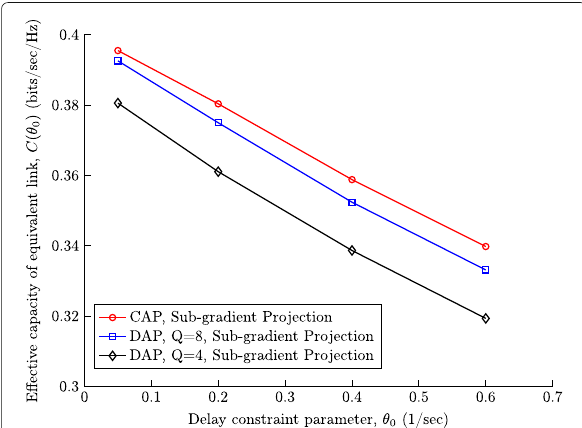
Fig.5 Effectivecapacityversusdelayconstraint, θ 0 inaheterogeneous 3-hop AF relay network; B 0 = 10 − 5 , ¯ s 0 = 2 dB, m 0 = 1, ¯ P 0 = 1 W/Hz; ¯ s = 3 dB, m = 1, ¯ P = 1.5 W/Hz; ¯ s = 4 dB, m = 2, ¯ P = 1 W/Hz 1 1 1 2 2 2